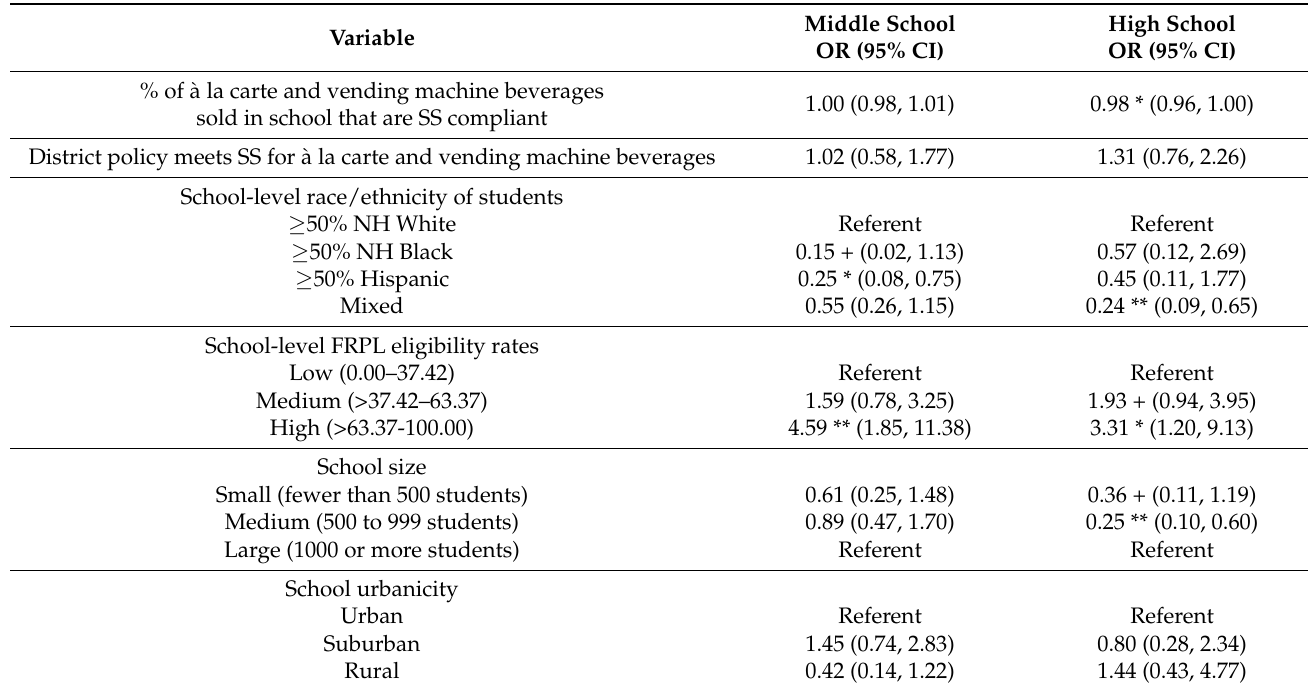
Table A2. Logistic regression results predicting student consumption of Smart Snacks non-compliant beverages at the 60 kcal threshold by school